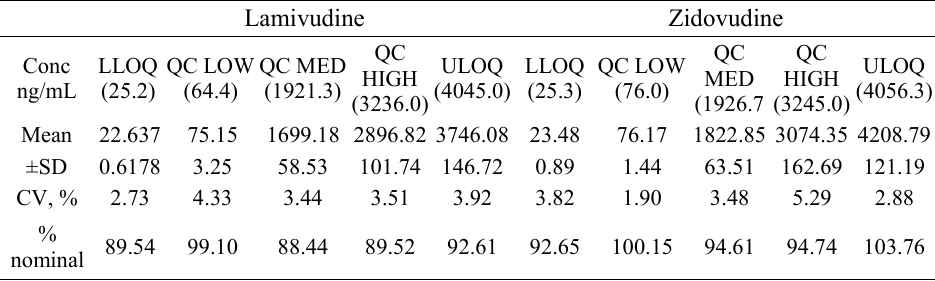
Table 4. Within run accuracy analysis for LAM and ZID in human plasma.